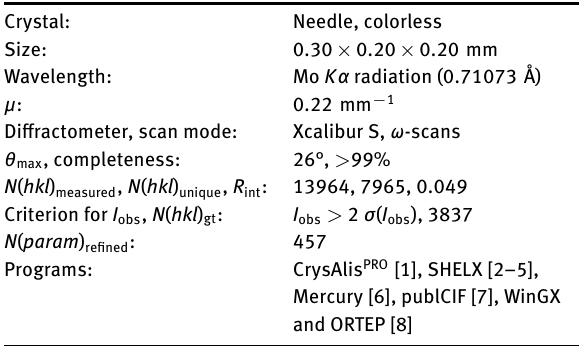
Table 1: Data collection and